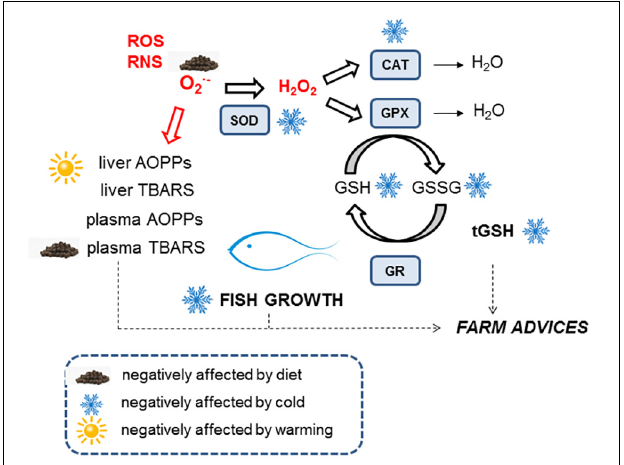
FIGURE 4 | Summary of redox response throughout temperature fluctuation of gilthead sea bream. Explanation is provided in the Discussion section.